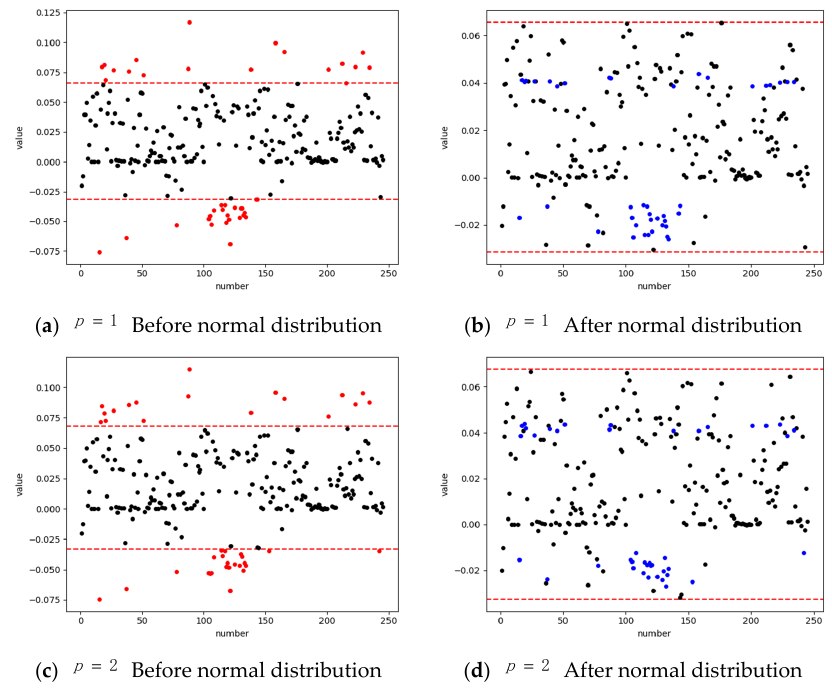
Figure 8. Distribution of values in the first two dimensions. Black represents normal points; Red represents the abnormal point before processing; Blue represents the normal point from the abnormal point after processing.